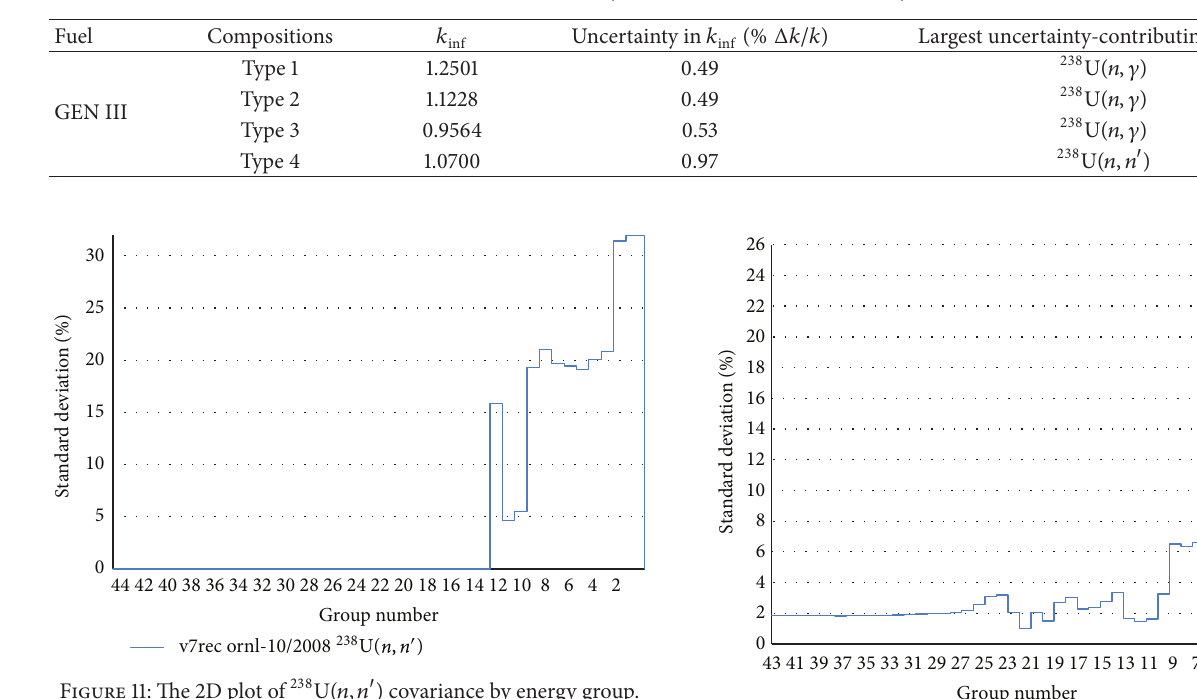
Figure 10: The sensitivity of 238 U( 𝑛, 𝑛 󸀠 ) as function of energy. Table 7: Uncertainty in 𝑘 inf in GEN-III fuel assembly.